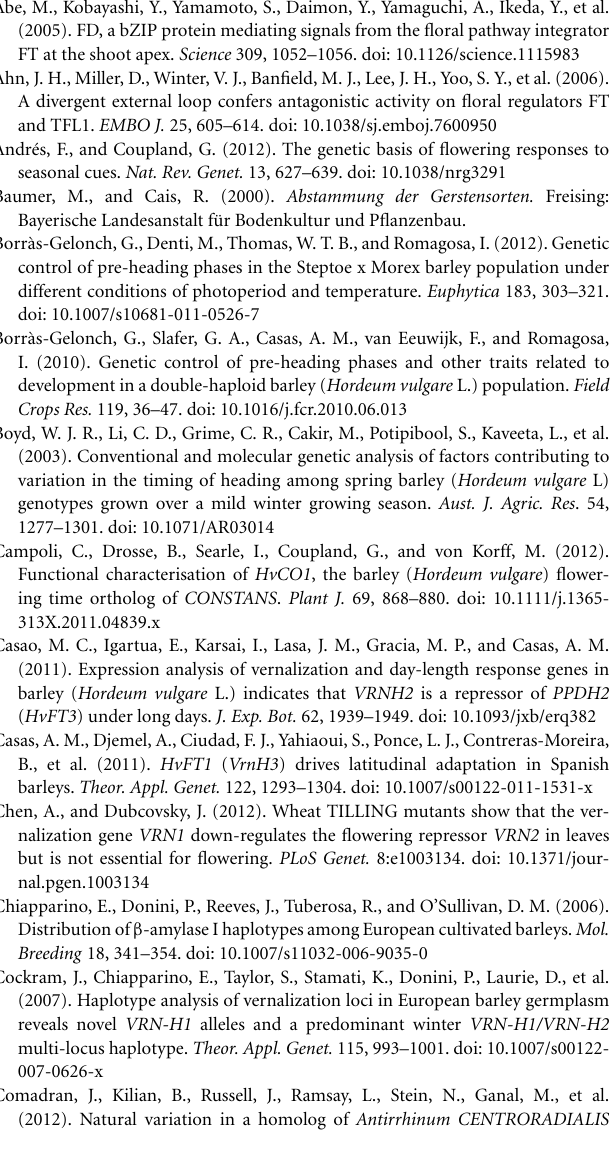
Table S1 | Barley accessions surveyed in this study classified according to the genetic constitution at vernalization and photoperiod genes. Countries of origin and row number are also